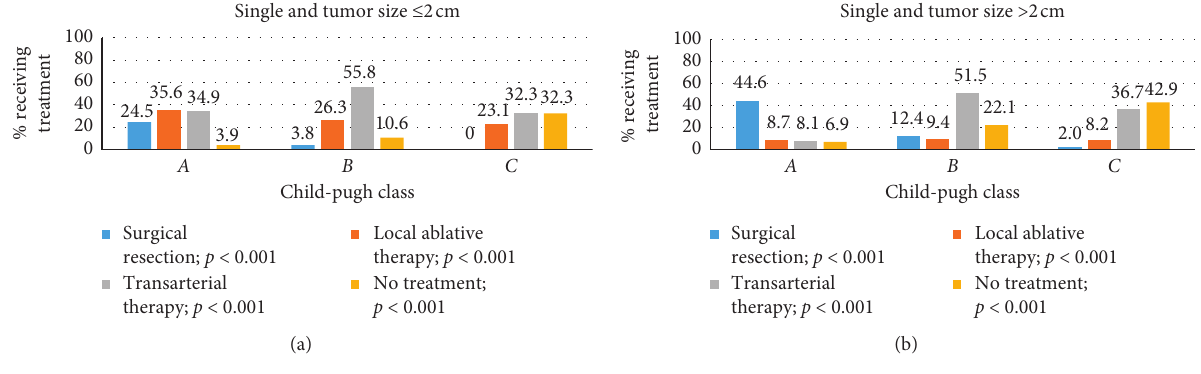
Figure 2: Proportion of the treatments performed for a single lesion according to Child–Pugh class. (a) Tumor size ≤ 2cm for surgical resection, local ablative therapy, transarterial therapy, and no treatment (all p < 0 . 001). (b) Tumor size > 2cm for surgical resection, local ablative therapy, transarterial therapy, and no treatment (all p < 0 . (Table 3). The rate of application of systemic chemotherapy did not change significantly in both age and CPC groups over 10% ( p � 0 . 292 and p � 0 . 235, respectively). In particular, the proportion of patients with no treat- ment significantly increased with increasing age (29.3% vs.